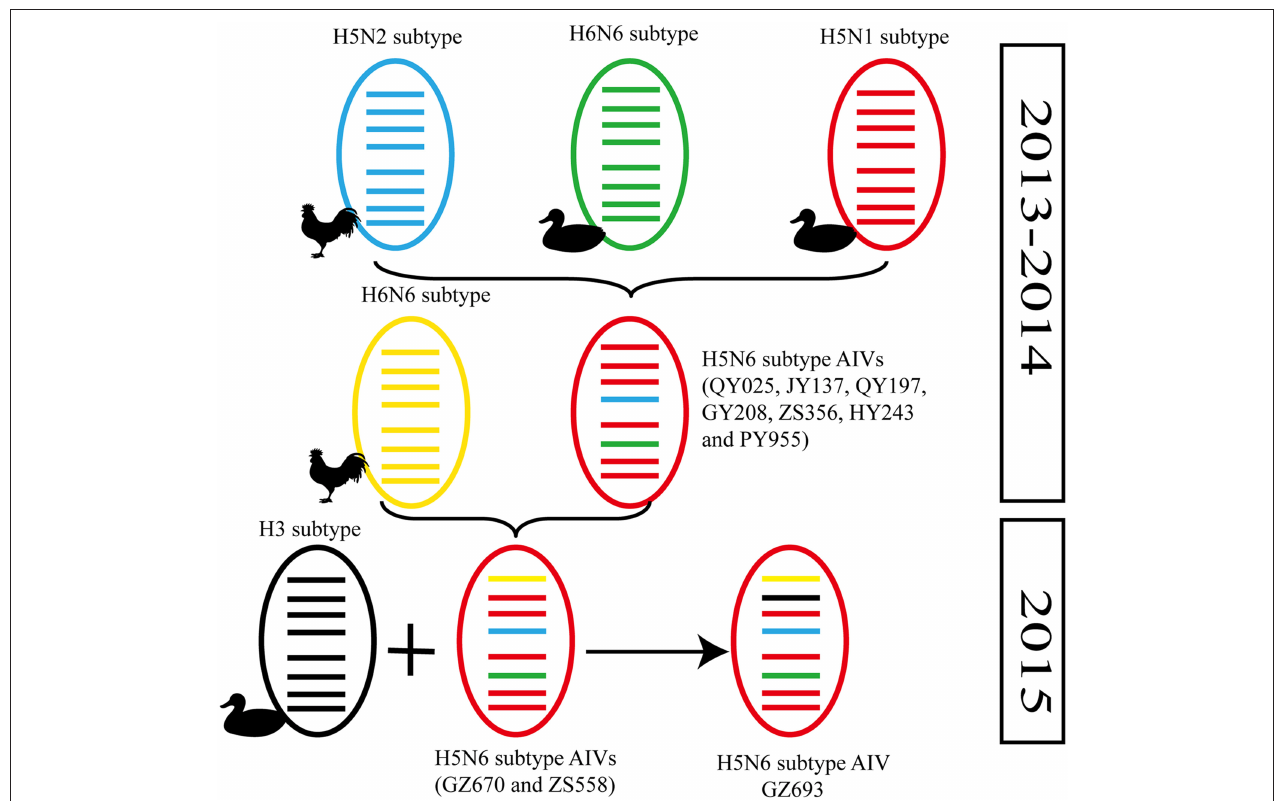
FIGURE 2 | Possible genetic contributions of known donor AIVs to the novel H5N6 avian influenza virus in Southern China. From top to bottom, the eight genes in each schematic virus particle are the PB2, PB1, PA, HA, NP, NA, M, and NS genes. Genes of the same lineage appear in the same